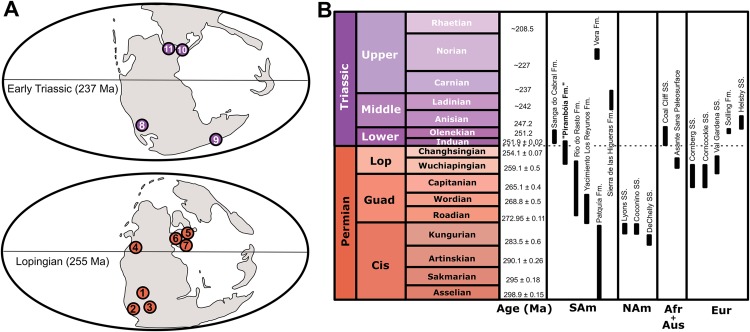
Paleogeographic and chronostratigraphic occurrence of the main units mentioned in the text.(A) Paleogeographic maps showing the main late Permian–Early Triassic Dicynodontipus- and Chelichnus-bearing localities: 1. Brazil (“Pirambóia Formation”), 2. Argentina (Yacimiento los Reyunos and Patquía formations), 3. South Africa (Asante Sana Paleosurface, Oudeberg Member of the Balfour Formation), 4. Western United States (Coconino, DeChelly and Lyons sandstones), 5. Germany (Cornberg Sandstein), 6. Scotland (Corncockle Sandstone), 7. Italy (Val Gardena Sandstone), 8. Argentina (Vera and Sierra de las Higueras formations), 9. Australia (Coal Cliff Sandstone), 10. Germany (Solling Formation), 11. England (Helsby Sandstone). (B) Chronostratigraphic position of the same units. Ages were taken from: Bonaparte (1966), Haubold (1971a, 1971b), Retallack (1996), De Klerk (2002), King et al. (2005), Lucas & Hunt (2006), Melchor & de Valais (2006), Krapovickas et al. (2010), Ogg (2012), Krapovickas et al. (2014), Dias-da-Silva et al. (2017), Marchetti, Voigt & Klein (2017) and Francischini et al. (2018). See text for further information. Maps modified from Scotese (2002).